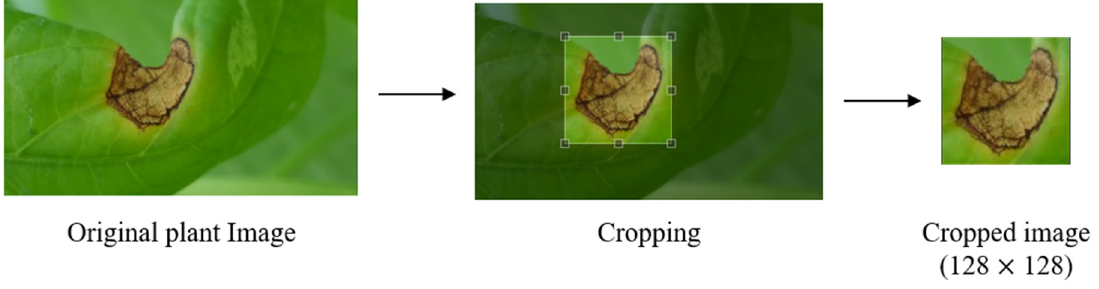
Figure 3. Process of image cropping.